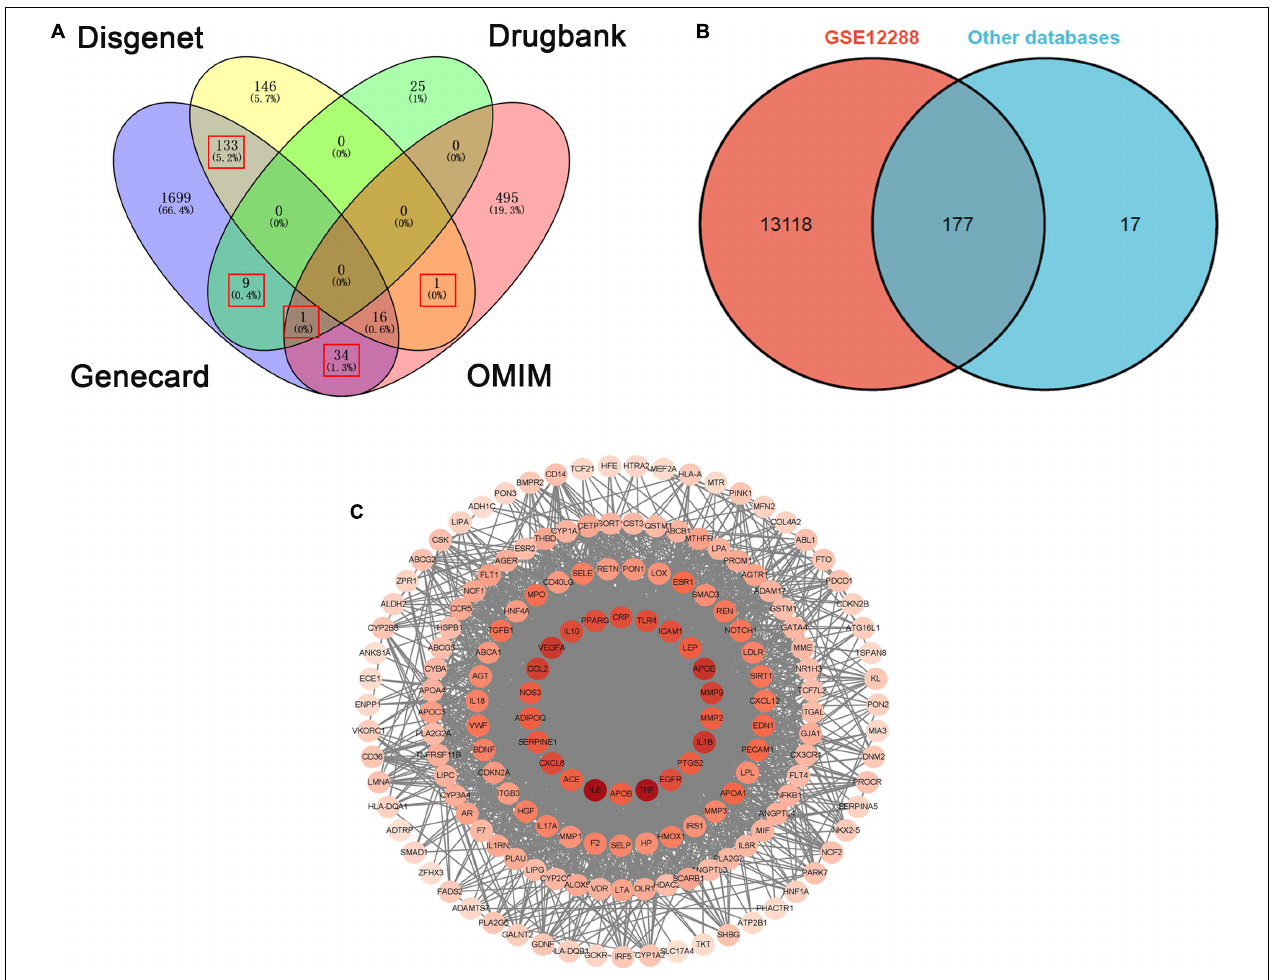
FIGURE 3 | The overlapped targets of CHD from four databases and PPI network of CHD targets. (A) The overlapped targets of CHD from four databases (Disgenet, Dregbank, Genecard, OMIM). (B) The overlapped targets of CHD from GSE12288 and the other four databases. (C) PPI network of CHD targets.